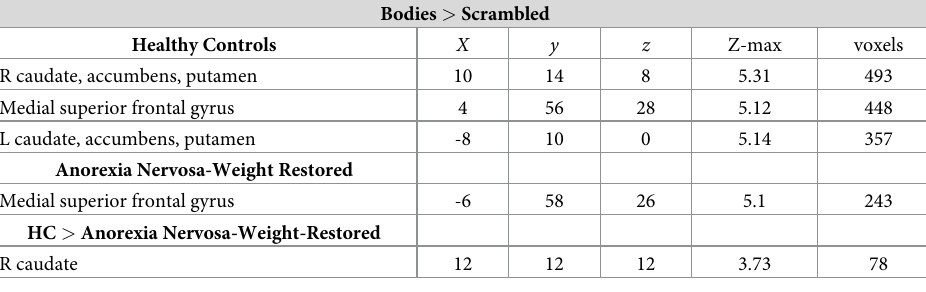
mPFC = Medial prefrontal cortex; R = right hemisphere; L = left hemisphere; HC = healthy controls; AN-WR = anorexia nervosa weight restored Coordinates are in MNI space.